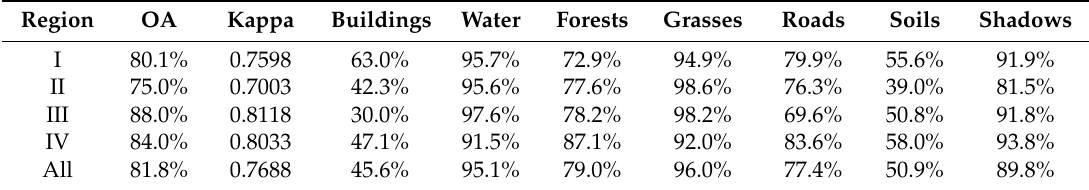
Table 5. Classification accuracies of the approach that used roads as training samples in the four test regions in terms of overall accuracy, Kappa coefficient, and F1-score for each